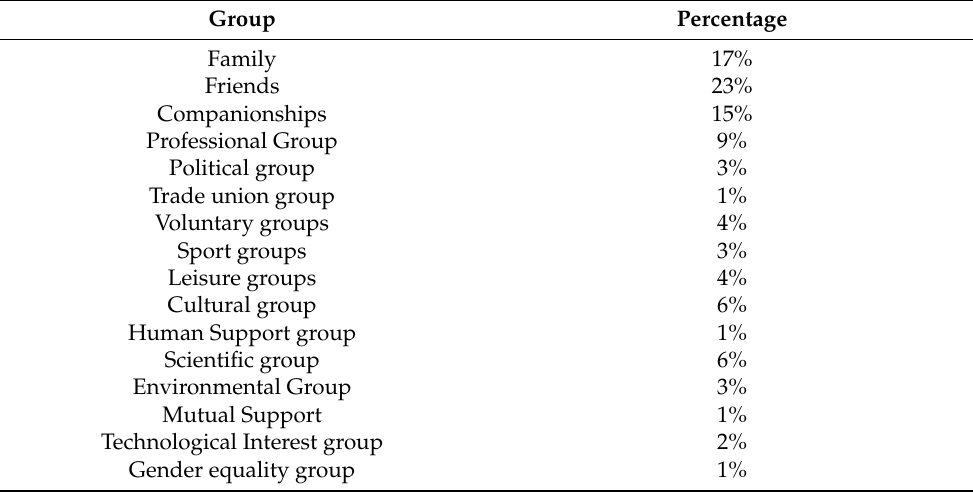
Table 8. Belonging to Social Groups in Social Networks